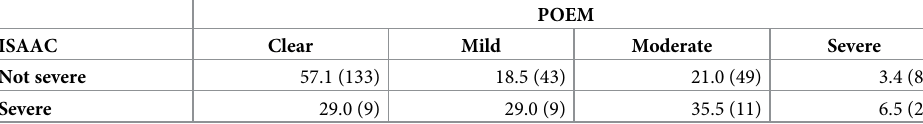
Table 4. Concordance between ISAAC and POEM severity